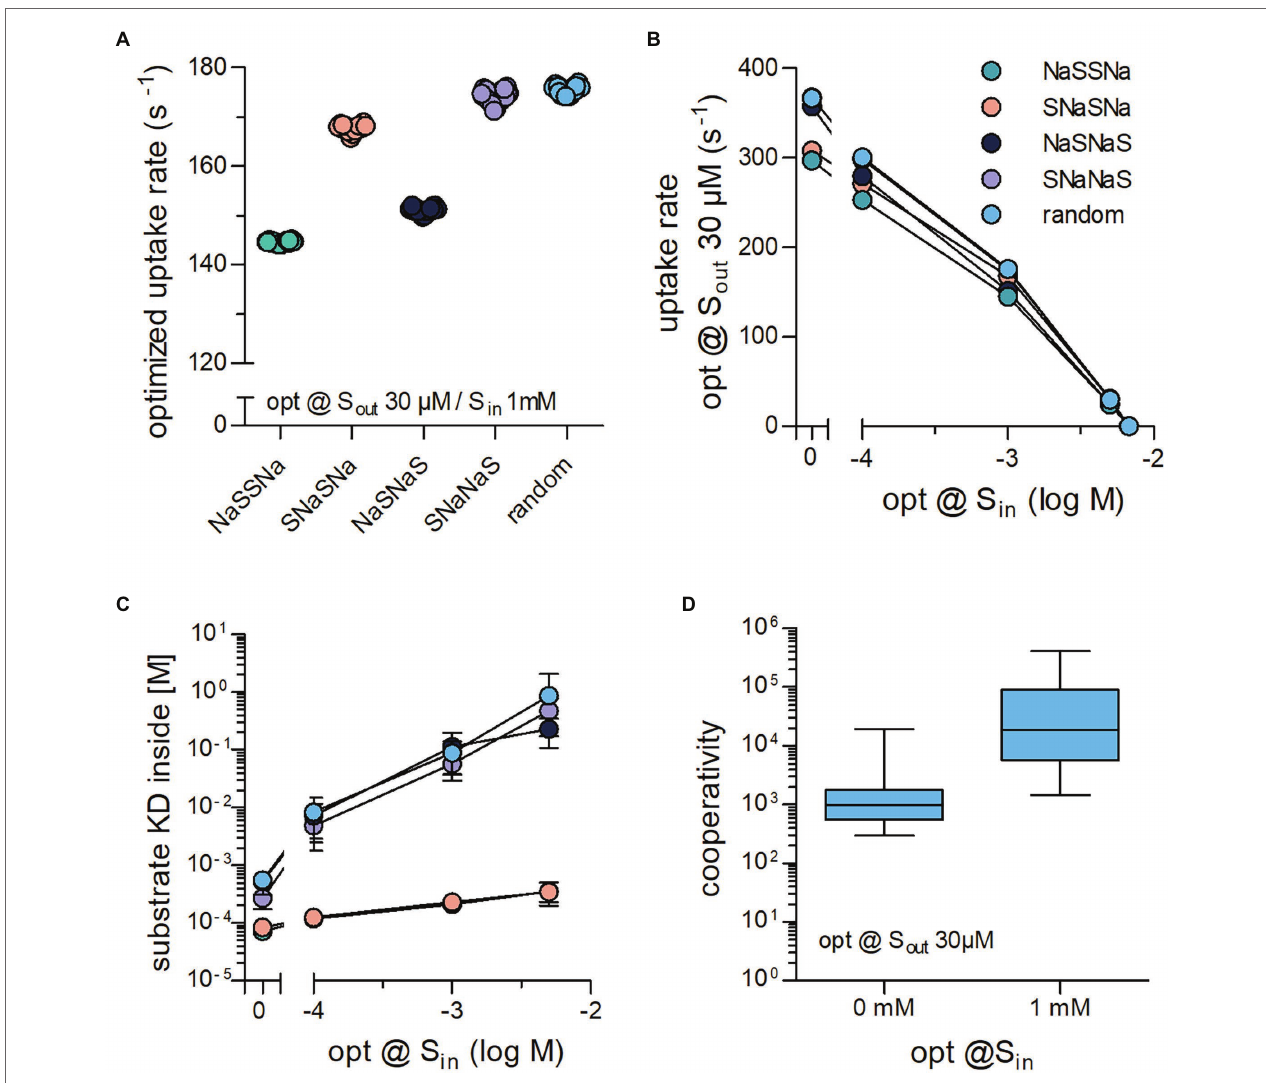
FIGURE 4 | Binding order of co-substrate and substrate affects the optimized substrate uptake rate, when S in is high. (A) Shown are the substrate uptake rates for transporters, which operate according to the reaction schemes illustrated in Figures 1A, 2A–D and which were optimized for 30 μ M S out and 1 mM S in . The optimized substrate uptake rate differed between reaction schemes. The data are the rates obtained from 20 optimization runs. (B) Plotted are the substrate uptake rates for all reaction schemes optimized for 0 mM, .1 mM, 1 mM, 5 mM, and 6.75 mM S in , respectively. The data are means ± SD of the substrate uptake rates obtained from 20 optimization runs. At 6.75 mM S in , the substrate uptake rate was zero for all reaction schemes. This is due to the fact that the concentrative power is defined by the transport stoichiometry (Na + : substrate = 2:1) and the Na + gradient rather than the reaction scheme: With a gradient of 150 mM external to 10 mM internal Na + , the concentrative power of the transporters is 225, which yields 6.75 mM S i at 30 μ M S out (C) Shown are K D values for the substrate binding to the inward-facing conformation for all reaction schemes of transporters optimized to 0 mM, .1 mM, 1 mM, and 5 mM S in , respectively. While the absolute values of this K D differed between schemes, they all rose with increasing S in . (D) The random binding order scheme, allows for Na + and substrate to bind in a cooperative manner: The affinity for substrate is high when Na + is bound and low in its absence. Cooperativity was defined as the ratio of the K D of substrate binding to the inward-facing conformation in the absence and presence of Na + . Transporters optimized for 1 mM S in displayed larger cooperativity values than those optimized for 0 mM S in ( p < .0001; Wilcoxon signed rank